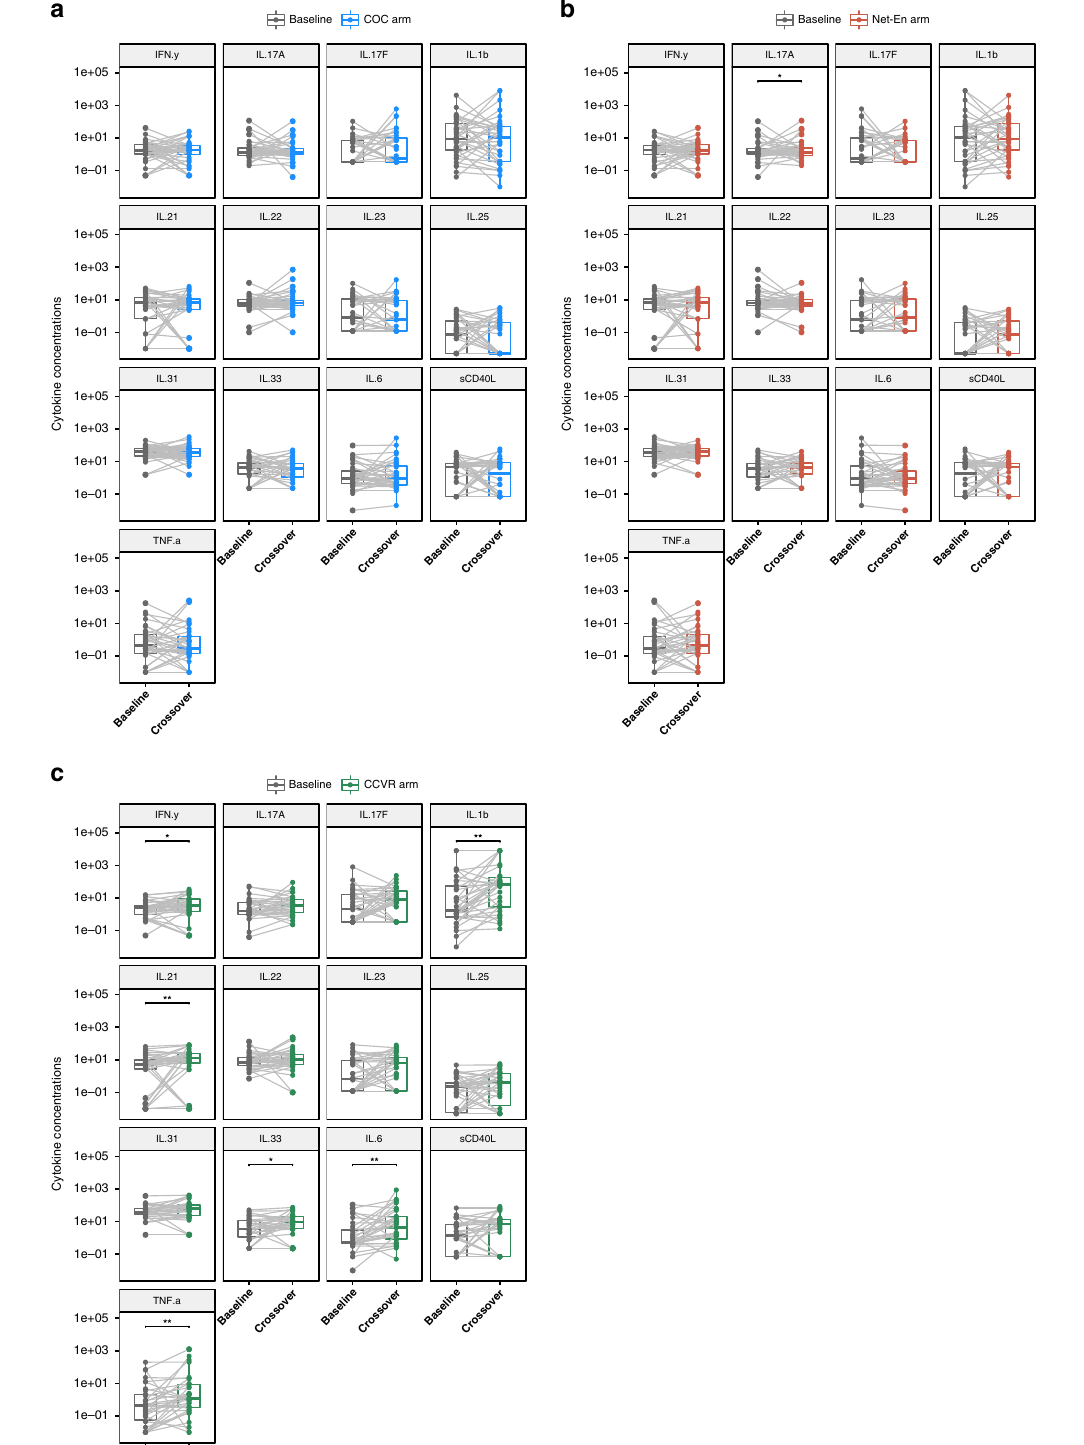
CST, although CCVR was associated with a nonsign fi cant increase in in fl ammation (OR: 3.1, 95% CI: 1.0 – 10.9, P = 0.072). When comparing adolescents in the CCVR and Net-En arms at cross- over, no signi fi cant associations were found with in fl ammation group or CST (Supplementary Table